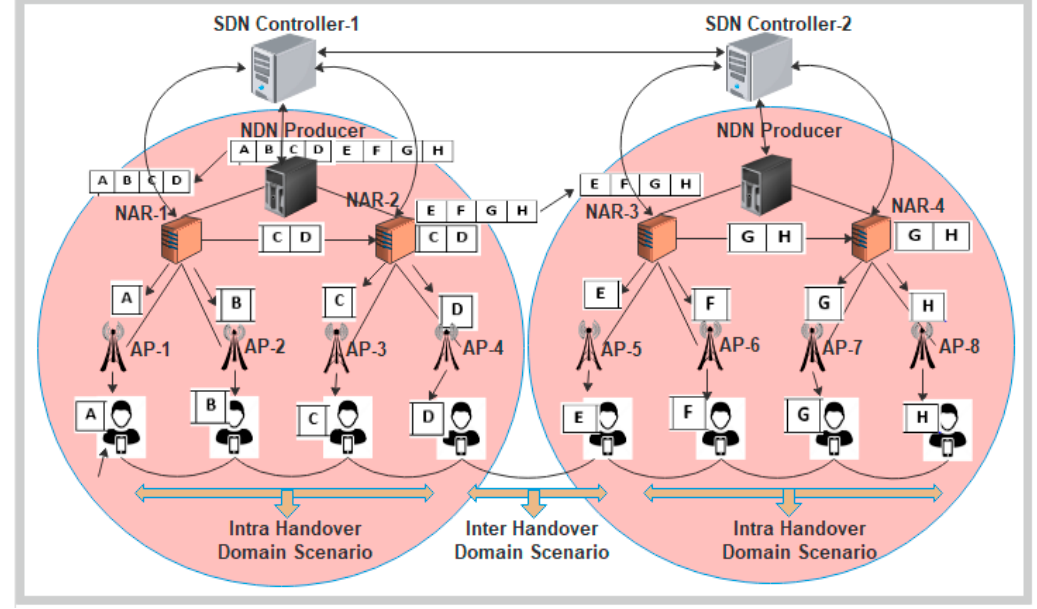
Figure 6. Inter-domain handover supervision